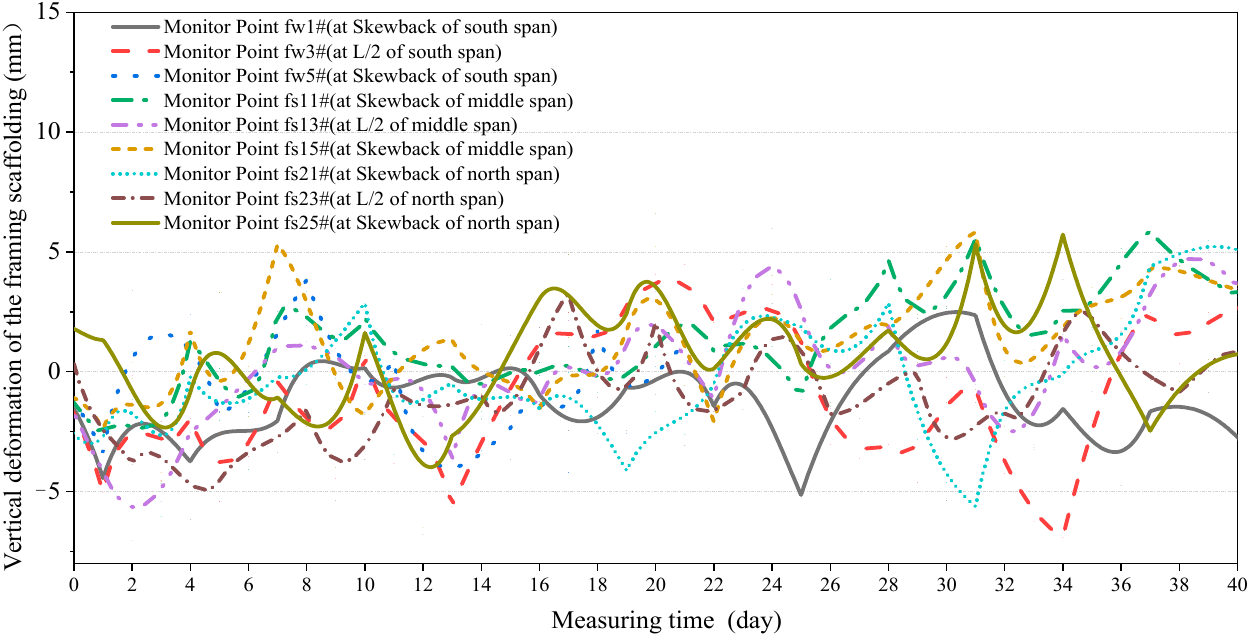
Figure 15. Monitoring results of vertical deformation of framing scaffolding.